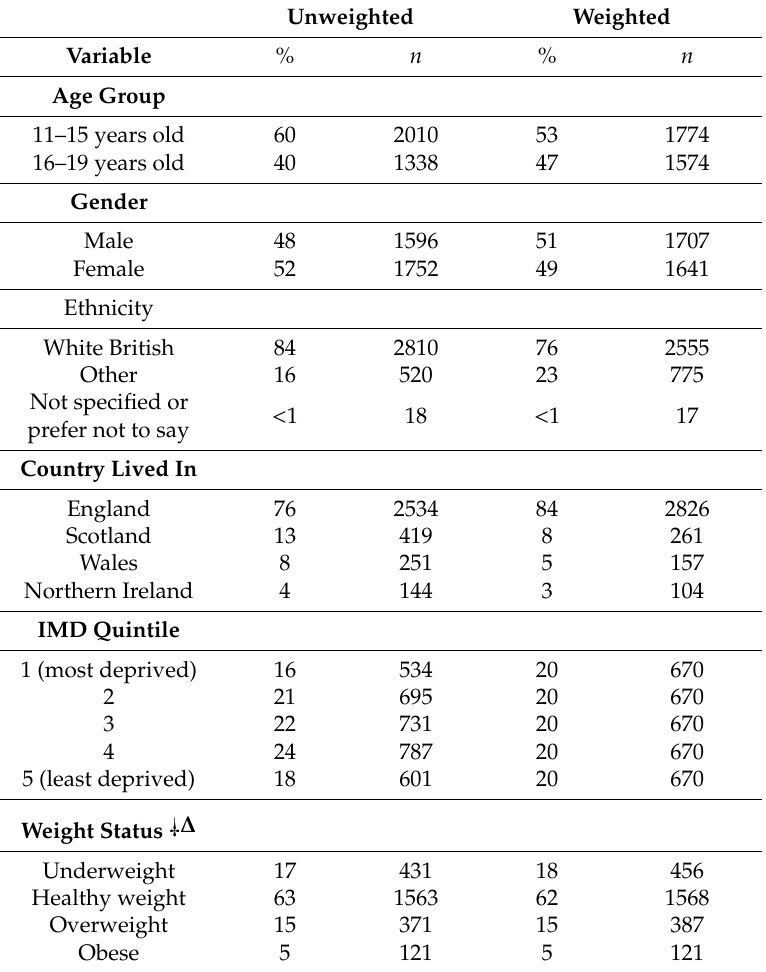
Table 1. Sample profile based on unweighted and weighted frequencies.